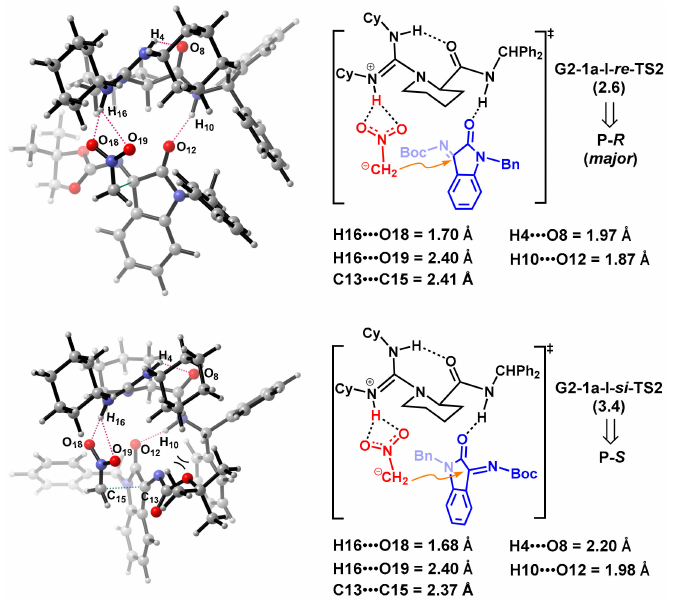
Figure 7. Optimized structures of transition states and the relative Gibbs free energies (kcal · mol − 1 ) in the aza-Henry reaction between N -Boc ketimine (R1a) and nitromethane (R2) catalyzed by guani- dine G2.